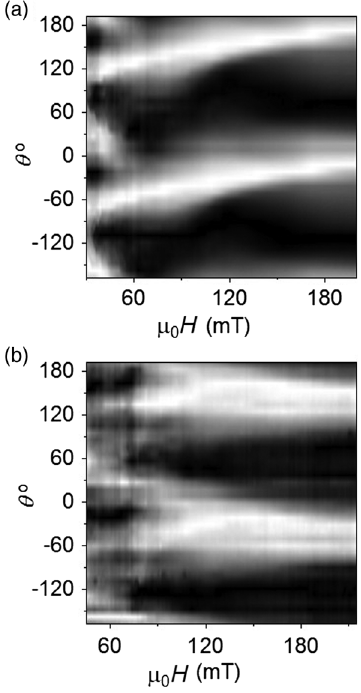
FIG. 3 2D gray-scale plots of the normalized AMR versus magnetic field for (a) PC1 and (b) PC2. Lighter color indicates higher resistance (black ¼ 0 ; white ¼ 1 ). The transitions from the fourfold (at low fields) to twofold AMR symmetry can be seen in both plots but at slightly different fields: ∼ 40 mT for larger PC1 (a) and ∼ 60 mT for smaller PC2